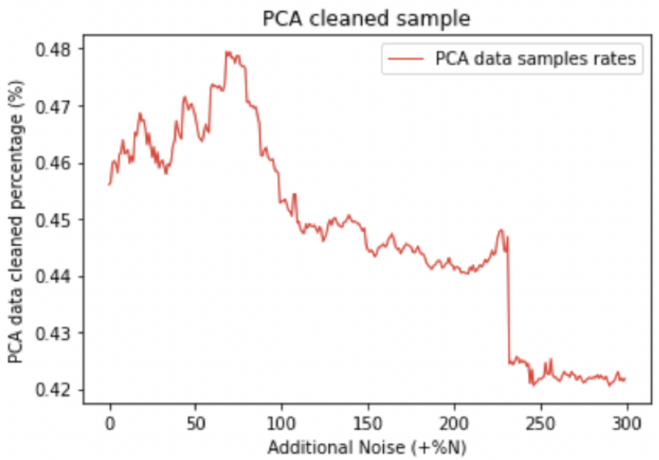
Figure 25. PCA cleaned data percentage (%).